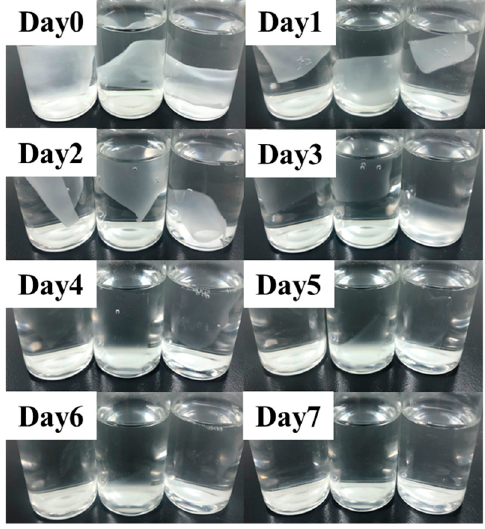
Figure 4. FESEM images of ( a ) GELF’, ( b ) ZGF’, ( c ) GELF and ( d ) ZGF.